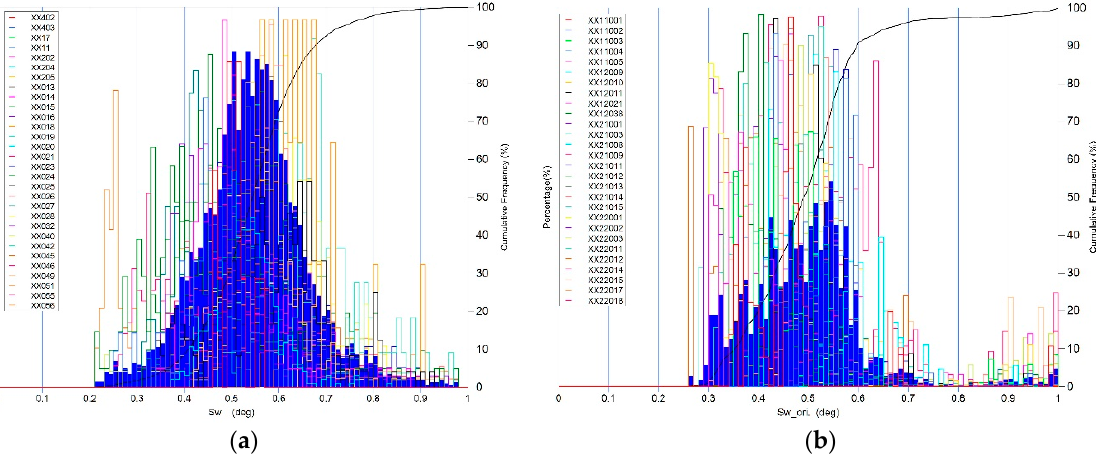
Figure 3. Histograms of the porosity for logging interpretation: ( a ) vertical wells; ( b ) horizontal wells (original). The blue-filled histogram is the cumulative distribution of all wells.